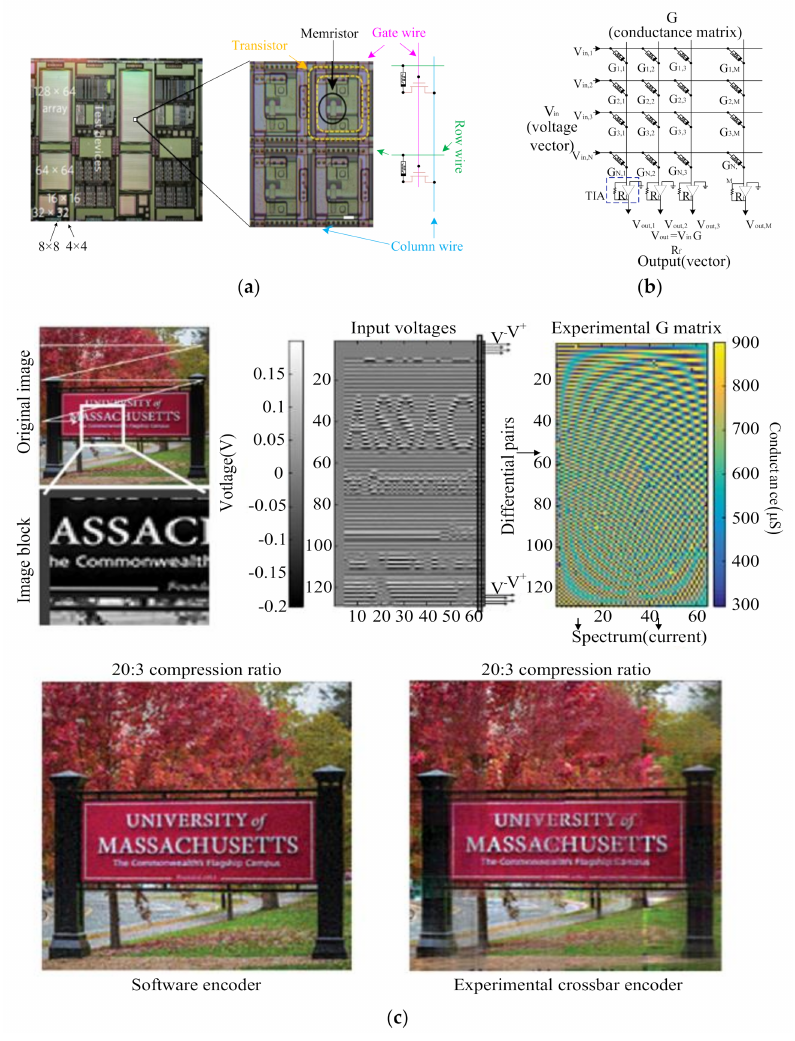
Figure 5. Application of crossbar array based on Ta/HfO 2 /Pd memristor in image processing. ( a ) memristor hardware structure; ( b ) memristor crossbar array; ( c ) memristor crossbar array to achieve image